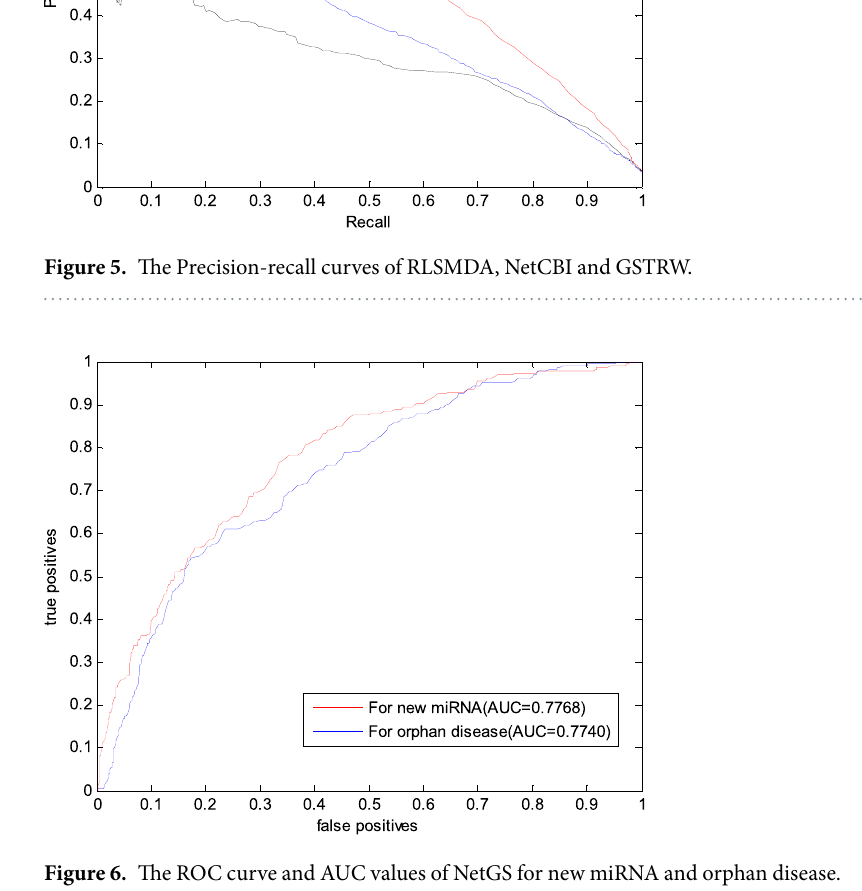
Figure 6. The ROC curve and AUC values of NetGS for new miRNA and orphan